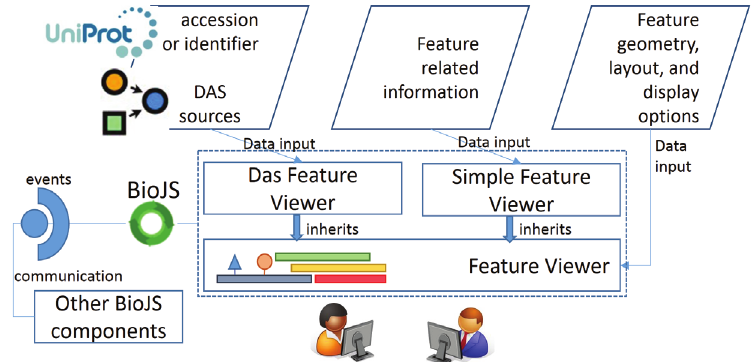
Figure 4. This graphic shows the FeatureViewer component and its extensions as well as the variations on the required input data. It also illustrates how BioJS handles the interaction with other components by means of